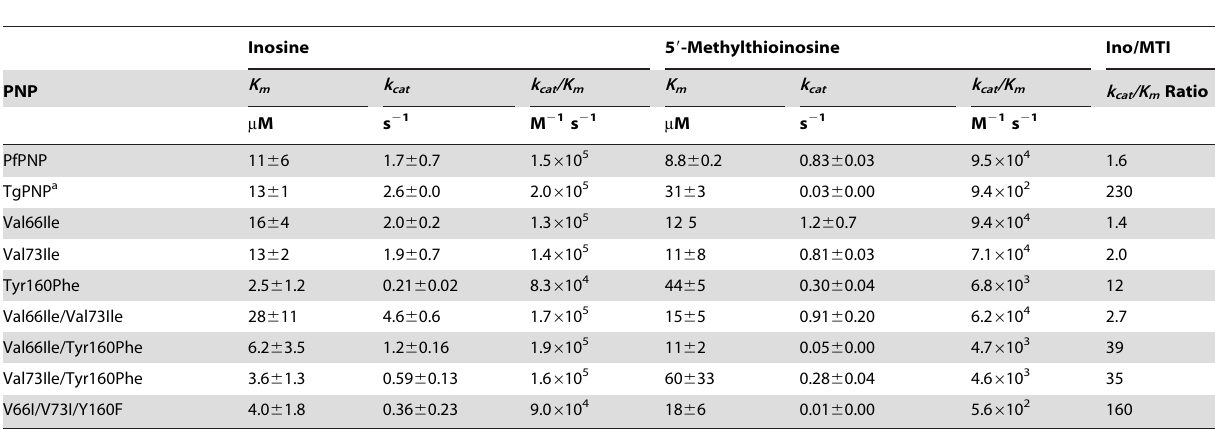
Table 2. Kinetic constants for P. falciparum PNP mutants simulating T. gondii PNP.